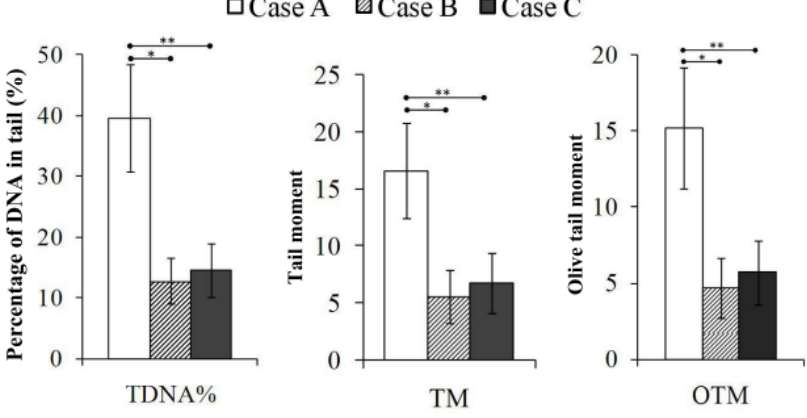
Figure 4. Quantitative analysis of residual DNA-DSBs in the lymphocytes of the three victims using the comet assay. *, Significant differences in TDNA%, TM and OTM were observed between Cases A and B, as analyzed by Student’s t -test, p = 0.000; **, Significant differences were observed between Cases A and C, as analyzed by Student’s t -test, p = 0.000; No difference was found between Cases B and C for all three comet